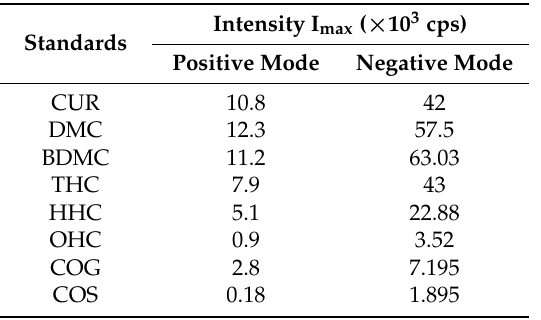
Table 1. The peak intensity of the curcuminoids and curcumin metabolites during direct infusion under positive and negative